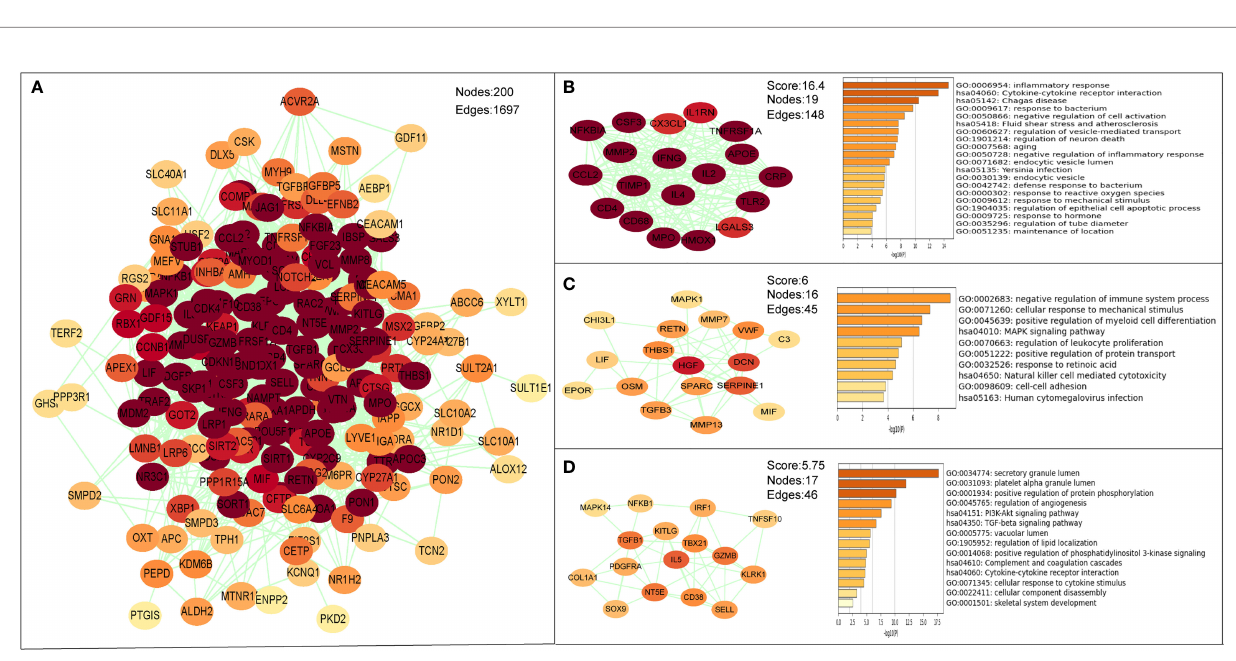
FIGURE 7 | The PPI network and clusters analysis of common targets. (A) PPI network of 202 common targets. (B – D) Three signi fi cant gene clustering modules and enrichment analysis of the modular genes.